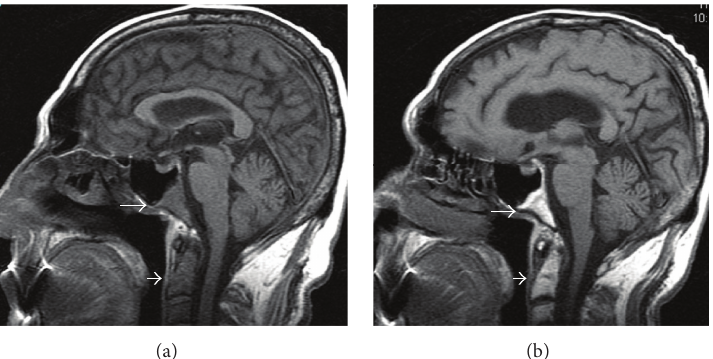
Figure 3: Initial sagittal nonenhanced T1-weighted MRI (a) show hypointensity of the clivus (arrow) and cervical vertebrae (short arrow) correspondingtoinfiltration.EightmonthslateraftersystemictherapysagittalnonenhancedT1-weightedMRI(b)showssignificantreduction of the hypointensity of the both clivus (arrow) and cervical vertebrae (short arrow).